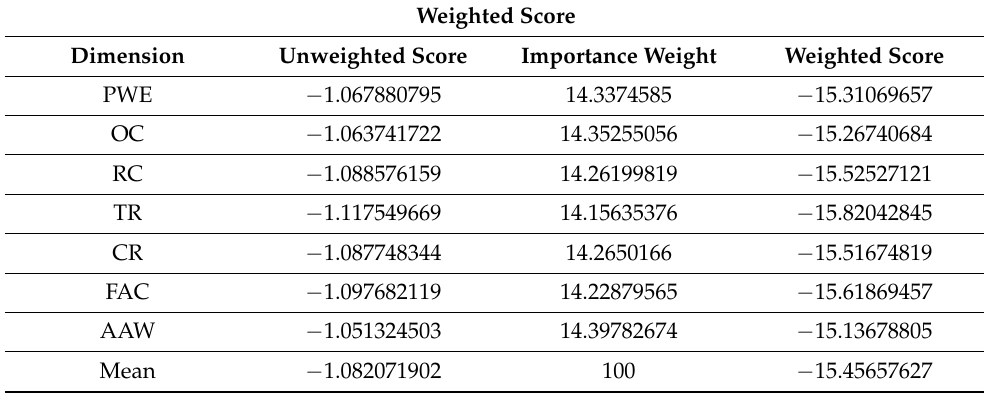
Table 7. Weighted average gap score for each